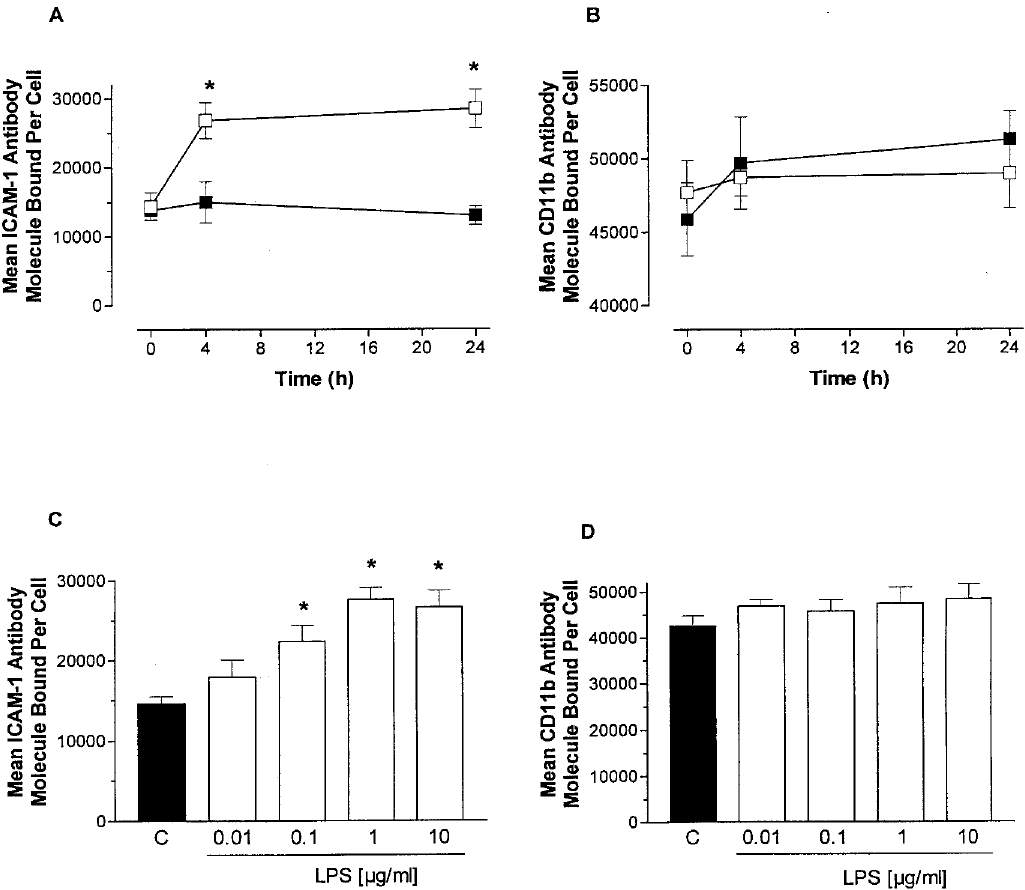
FIG. 1. Time course of the expression of (a) ICAM-1 and (b) of CD11b by J774.2 macrophages activated with endotoxin. J774.2 cells were incubated in the absence (solid squares) or presence (open squares) of LPS (1 m g/ml) for 0, 4 or 24h, respectively. Endotoxin caused a concentration-dependent increase in the expression of (c) ICAM-1 but not (d) of CD11b by J774.2 cells. Macrophages were treated with vehicle (C, saline; solid columns) or LPS (0.01–10 m g/ml; open columns) for 4h. At the end of experiments, adhesion molecule expression on the plasma membrane was quantified by FACS analysis. Data are expressed as mean±S.E.M. from triplicate determinations (wells) from three separate experimental days ( n =9). * P <0.05 represents significant difference when compared to control values.